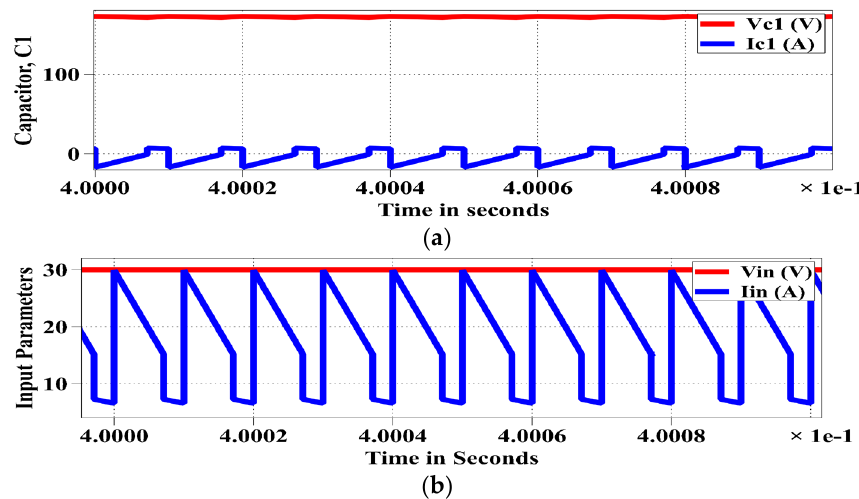
Figure 8. Current and voltage stress waveforms: ( a ) Capacitor, C 1 ; ( b ) Input source. Figure 9 illustrates the output voltage and current waveforms of the MQZS converter.